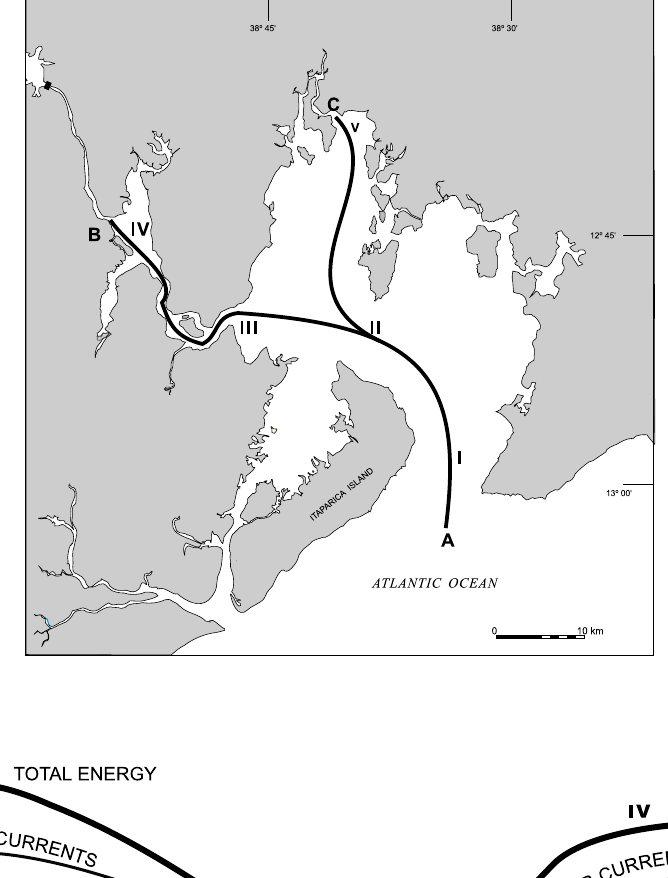
An. Acad. Bras. Ci. ,(2000) 72